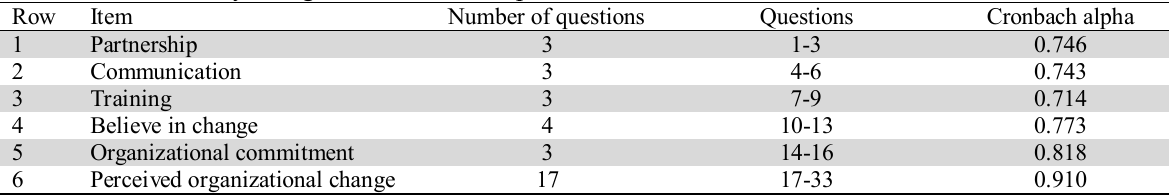
Details of the survey along with Cronbach